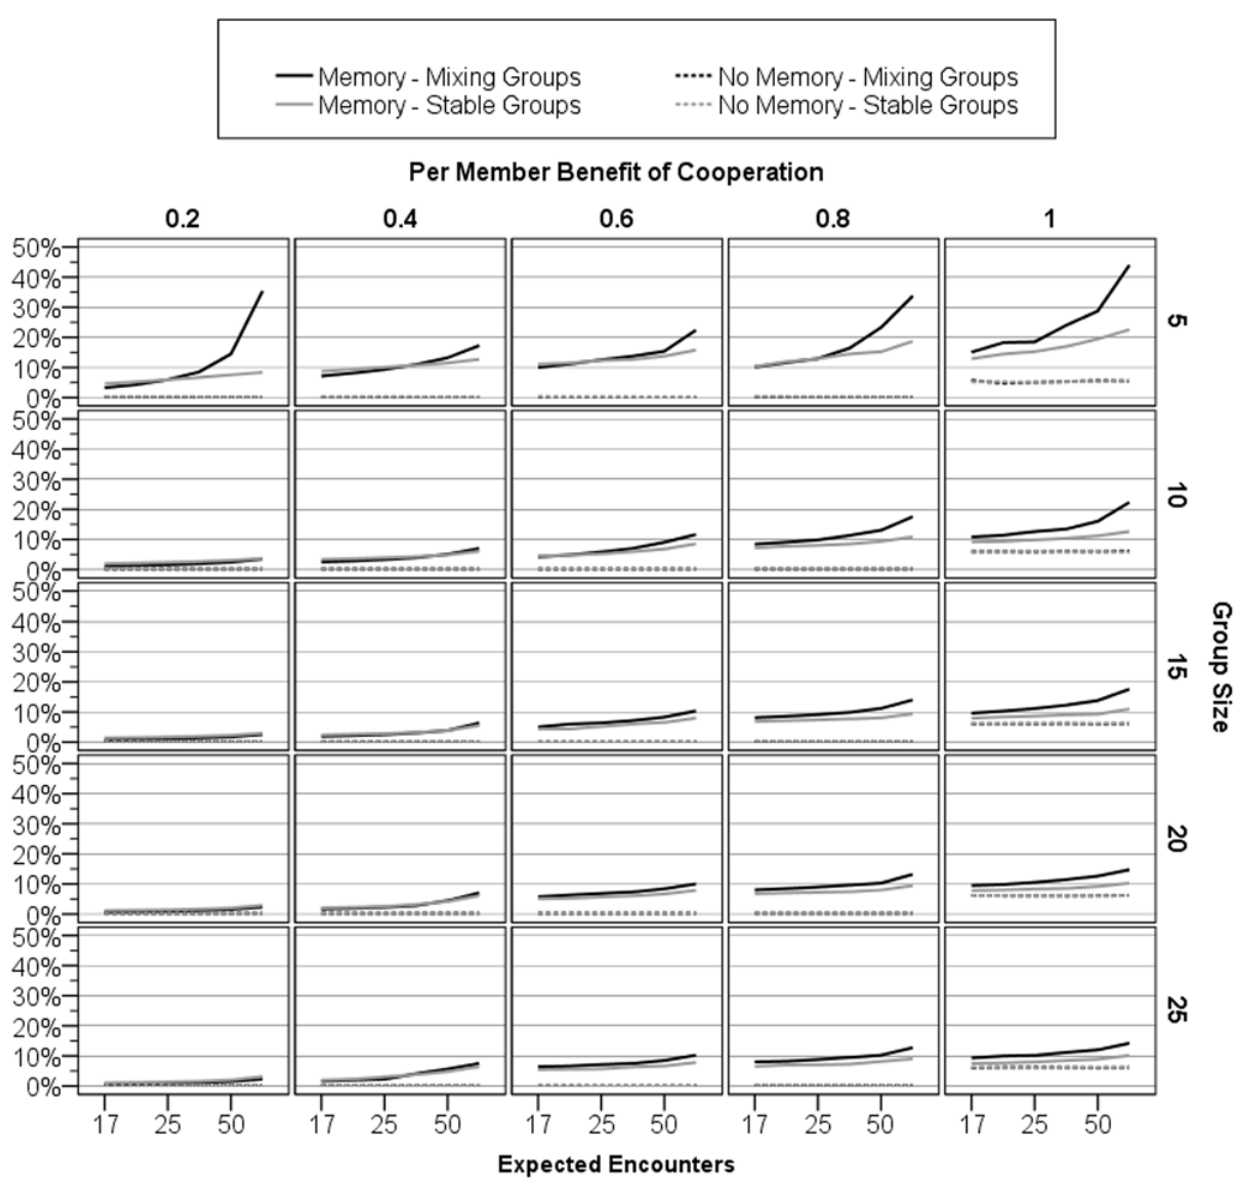
Fig 2. Final average values of Punish-Freeriding Probability . This figure plots the average willingness to punish of the last 500 generations of each